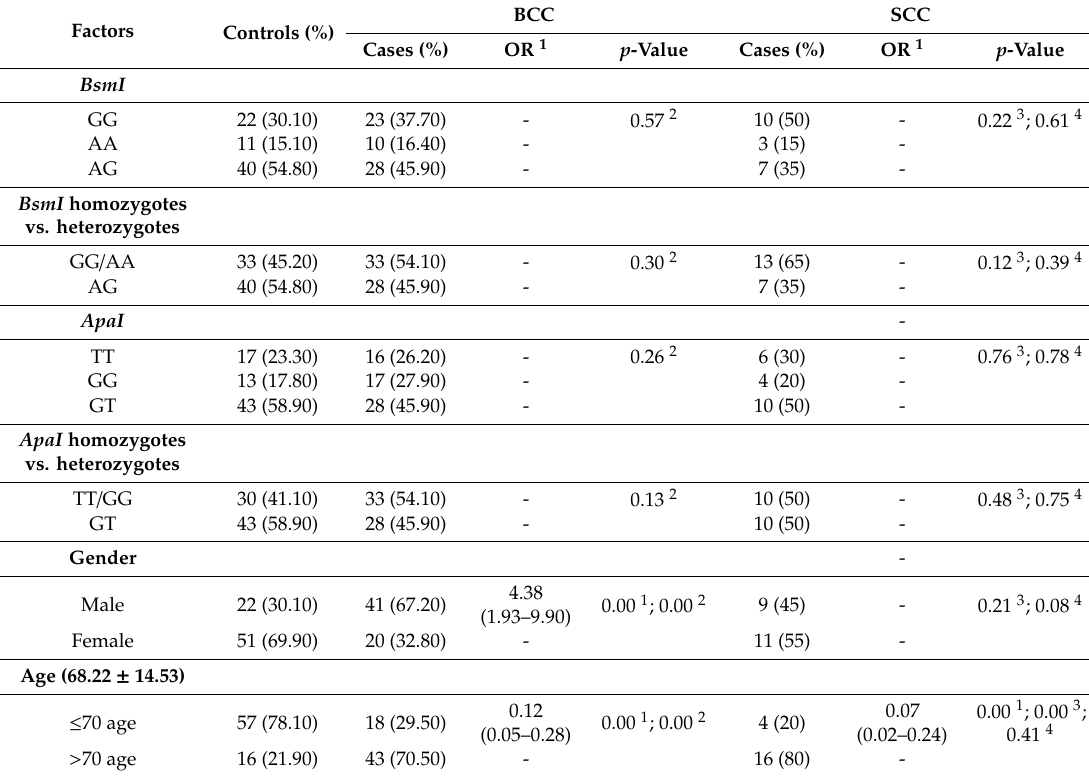
Table 1. Vitamin D receptor (VDR) genotype, gender, age and skin cancer